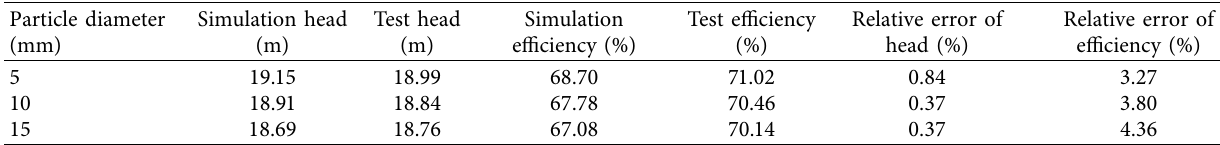
Figure 20: The experiment system and particles: (a) overall view of the test system, (b) side of the test system, (c) 5mm particles, (d) 10mm particles, and (e) 15mm particles. Table 3: Comparison of calculation and